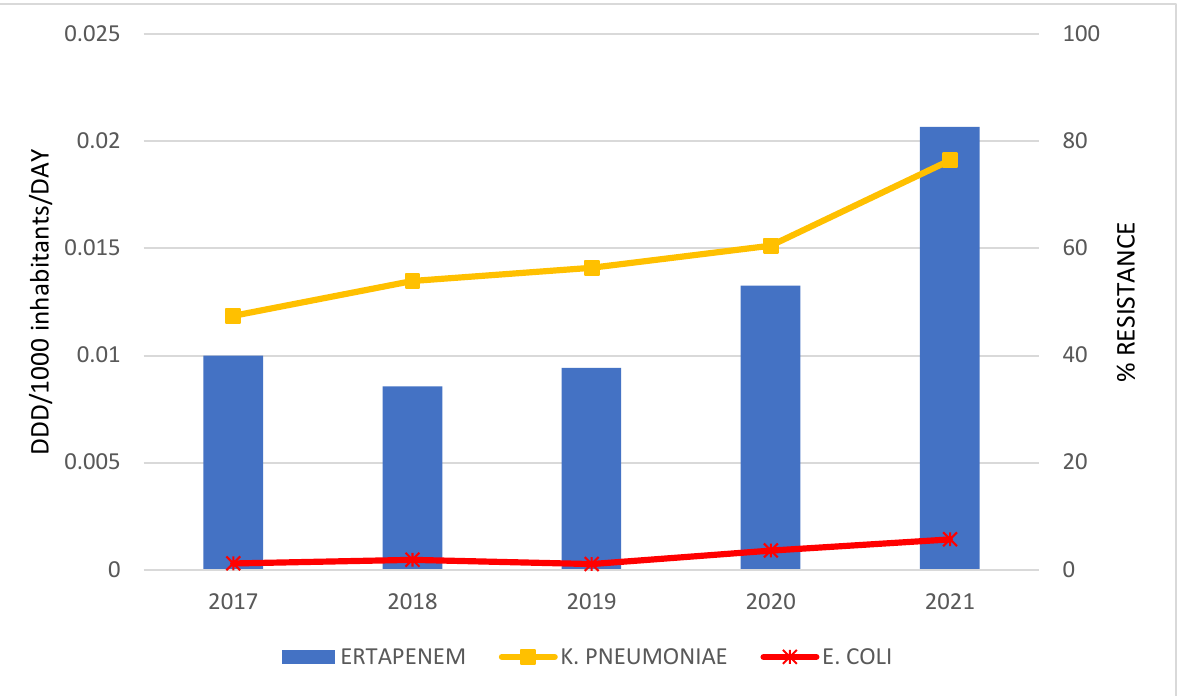
Figure 4. The correlation of ertapenem consumption and the resistance to ertapenem in bacteria during 2017 – 2021.